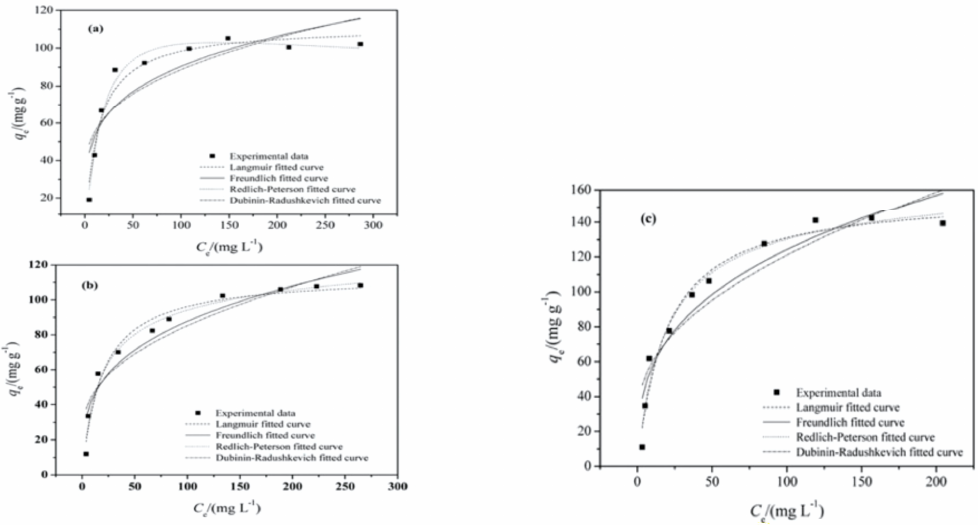
Figure 12. Langmuir and Freundlich model of MB adsorption on sawdust [32]. ( a ) monolayer MB ( b ) HA/Au nanocomposite adsorbent agent ( c ) miswak